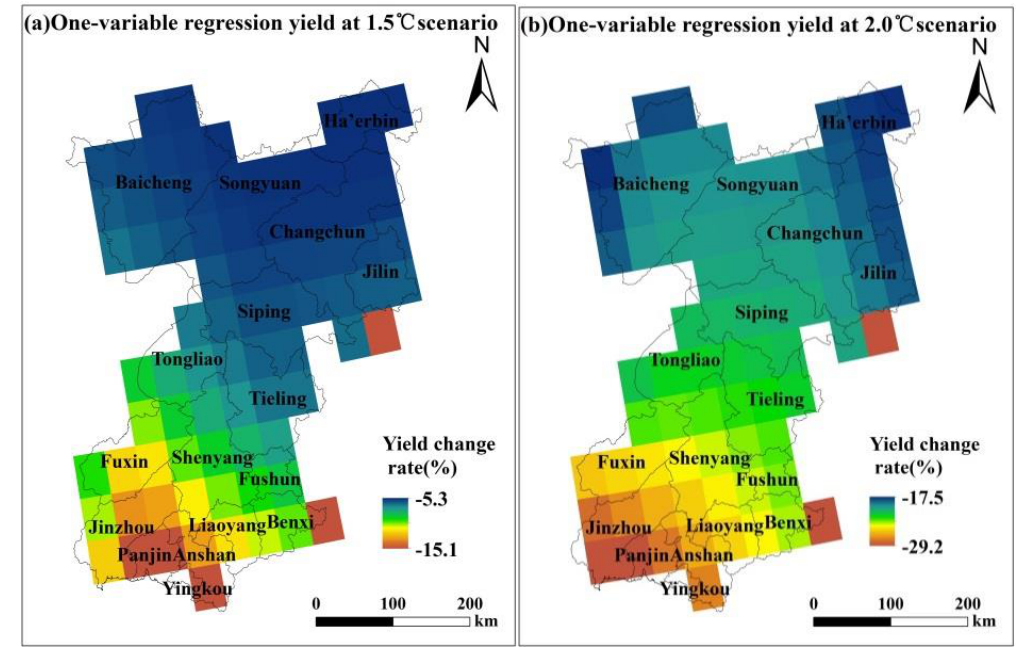
Figure 11. Distribution of the maize yield change in the Songlian Plain maize belt predicted by one-variable regression under the 1.5 °C ( a ) and the 2.0 °C ( b ) global warming scenarios.